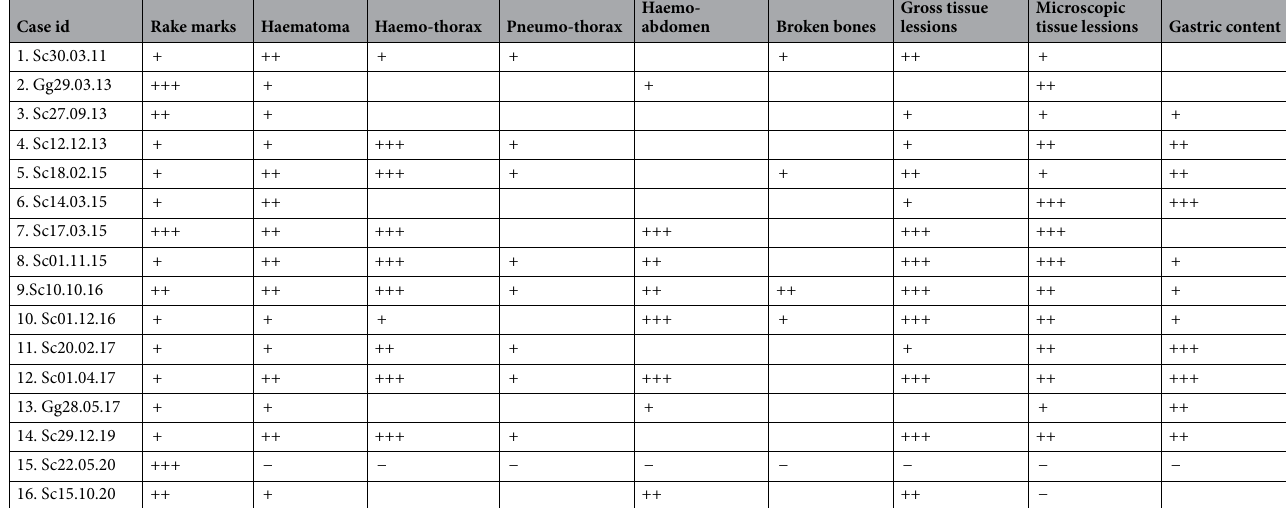
Table 2. Injuries observed on all 16 dolphins that had evidence of aggressive interactions with bottlenose dolphins. Severity was indicated as follows: (+) mild, (++) moderate, (+++) severe. Empty box denotes no lesion and ( – ) no data available. In pneumothorax column ( +) denotes presence and empty box absence. Note: gastric content was not representative in case 2 (Gg29.03.13) as it was kept under rehabilitation for 10